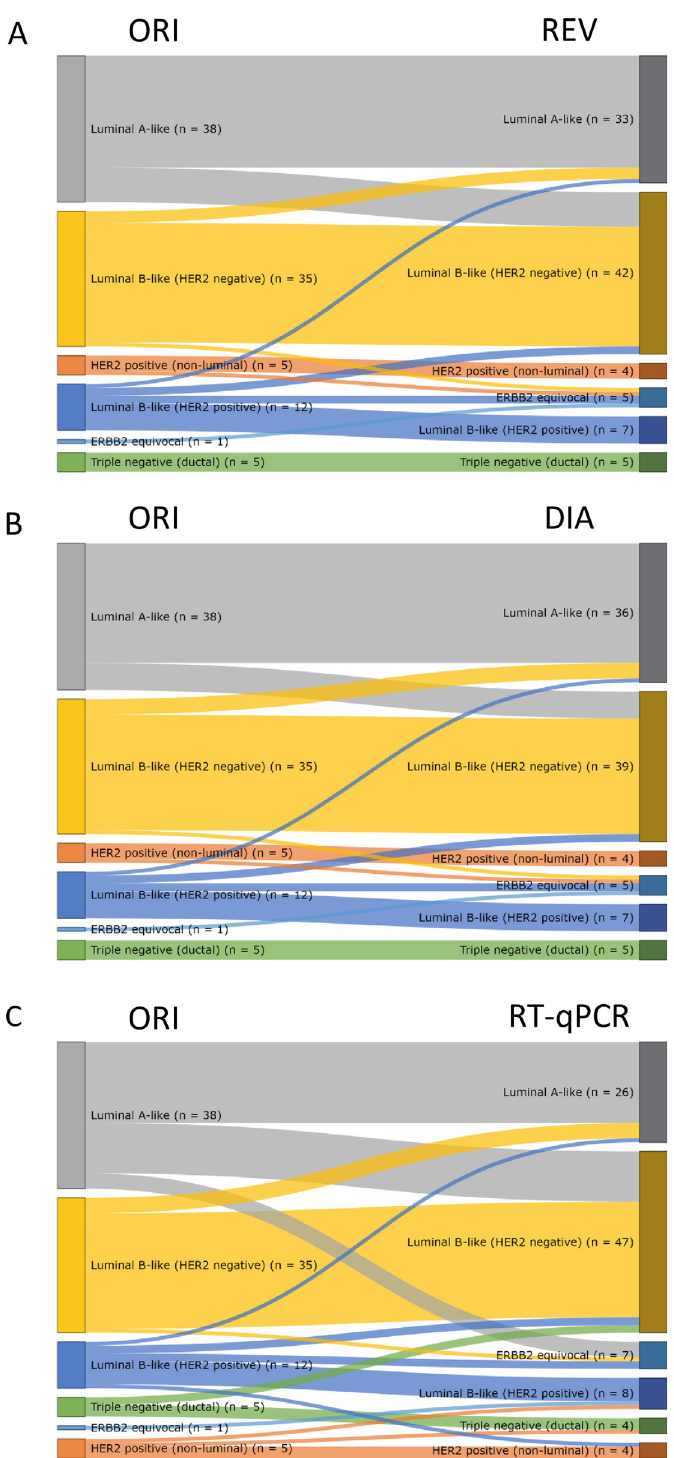
Fig 5. Subtype redistribution after re-evaluation (REV) (A), semi-automated analysis (DIA), (B) and RT-qPCR measurement (C).